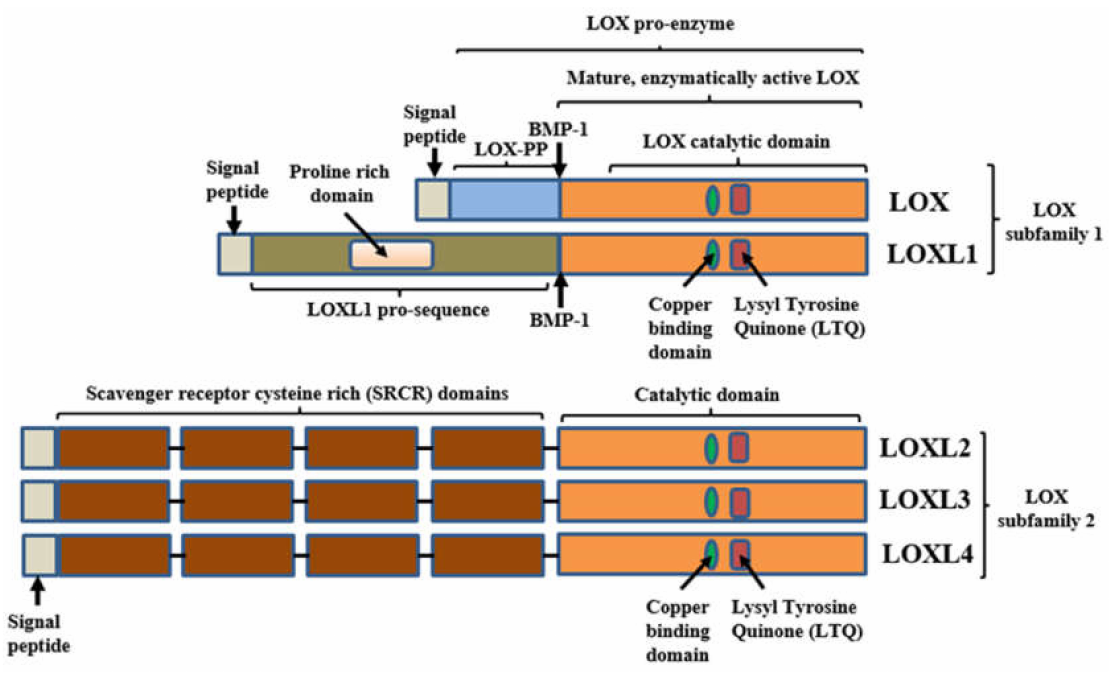
Figure 1. Structural elements of the lysyl-oxidases: The five lysyl-oxidases can be divided into two sub-families. The first includes LOX and Loxl1. These are synthesize as pro-enzymes that are cleaved by the BMP-1 protease (and in the case of LOX by additional proteases such as ADAMTS2/14) to release the mature active enzyme. The second subfamily includes LOXL2-4 and is characterized by a much less conserved N-terminal that is characterized by the presence of four scavenger receptor cysteine rich (SRCR) domains. The catalytic domain is highly conserved among the different lysyl- oxidases and includes a conserved copper binding domain and a unique lysyl tyrosine quinone (LTQ) element that is essential for the catalytic activity (for a more detailed discussion of the structure and enzyme function of LOX see this review [5]). In the case of LOX cleavage by BMP-1 also releases the N-terminal part, LOX-PP, which functions as a tumor